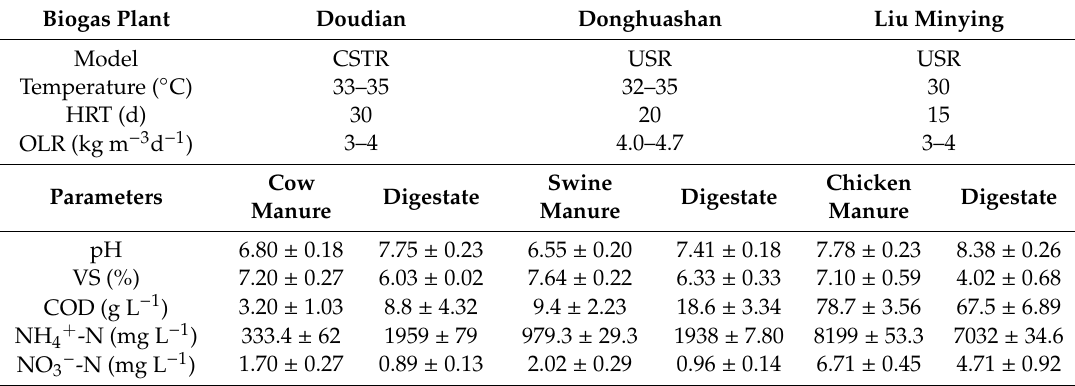
Table 1. The biogas plant parameters and characteristics of manure and respective digestate (n =